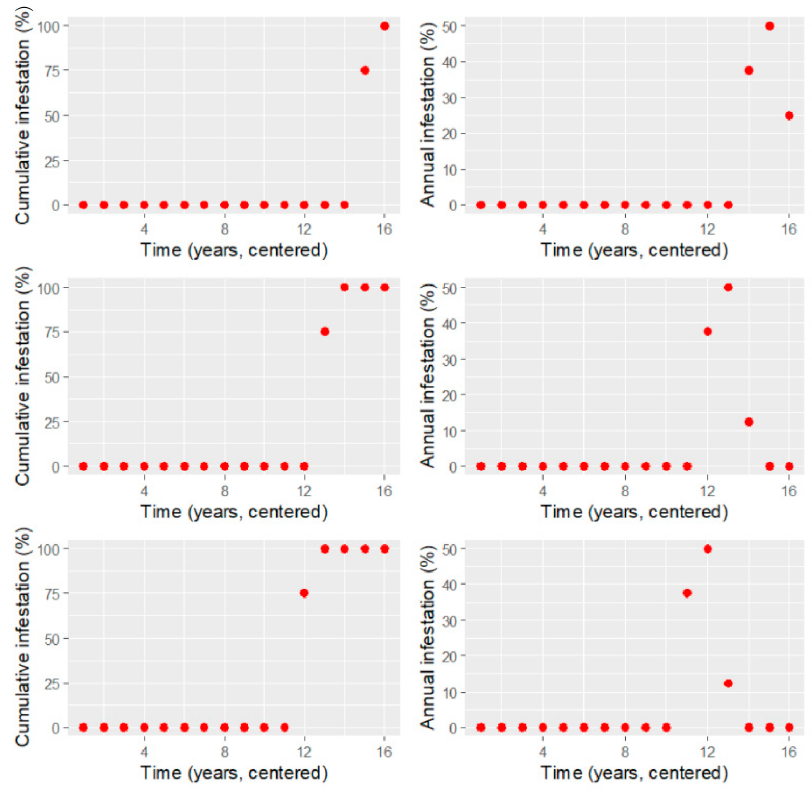
Figure A1. Three sample curves of cumulative ( left panels) and annual ( right panels) infestation percentages.